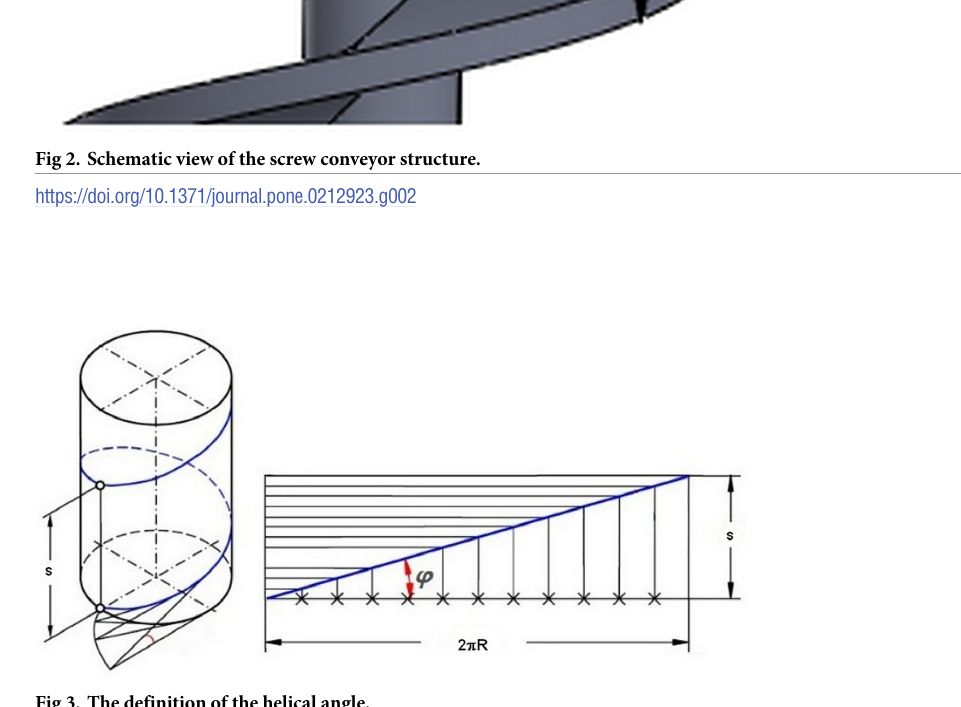
Fig 3. The definition of the helical